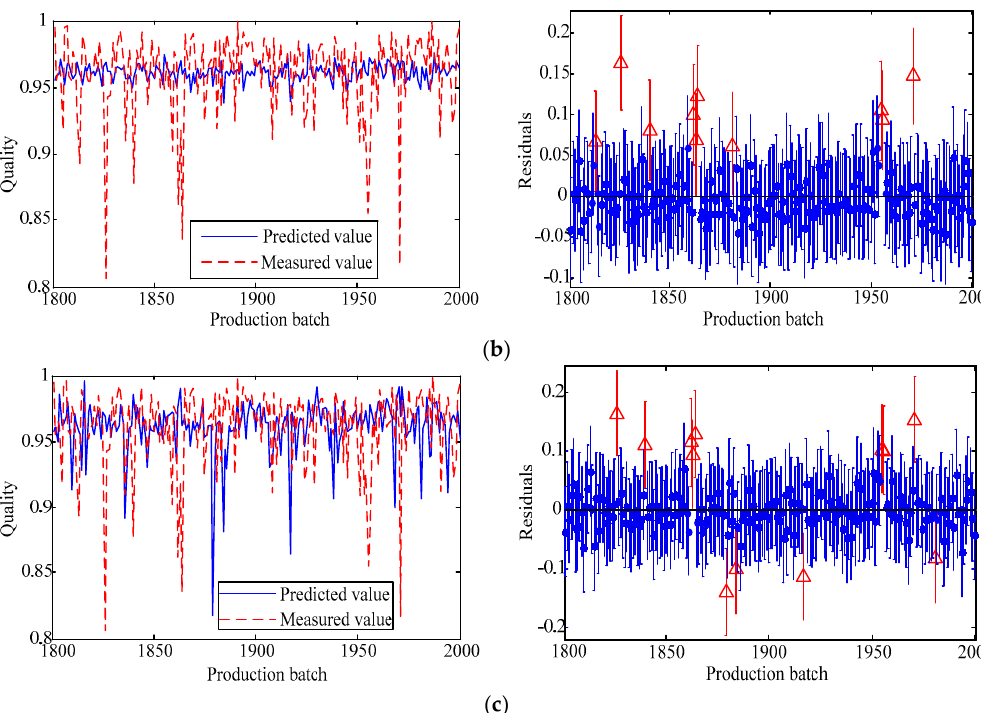
Figure 8. Prediction results of Case 2 using different models. ( a ) AE-based DRN with 19-40-40-1, ( b ) LSSVR, and ( c ) back propagation neural network (BPNN) with 19-12-1.